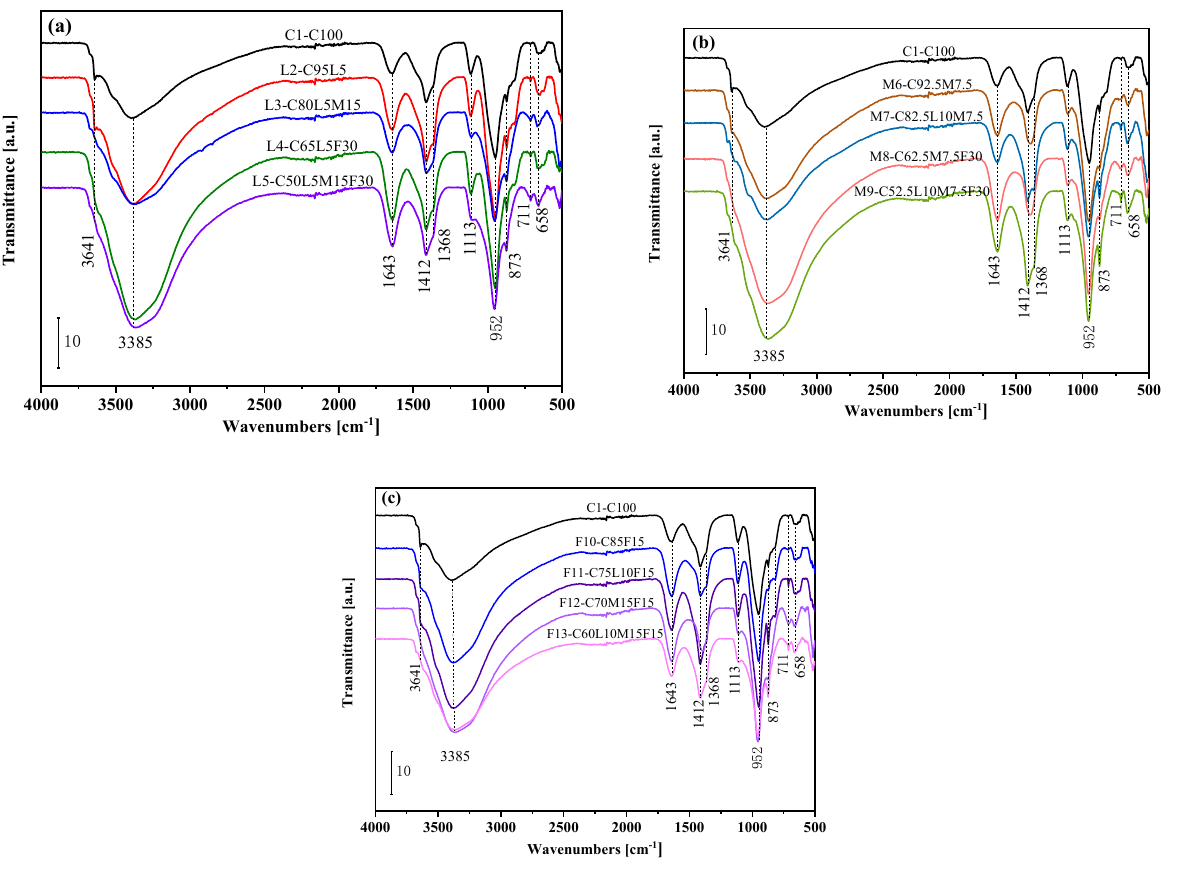
Figure 10. FTIR spectra analysis: ( a ) the control specimen and LS system; ( b ) the control specimen and MK system; ( c ) the control specimen and FA system.